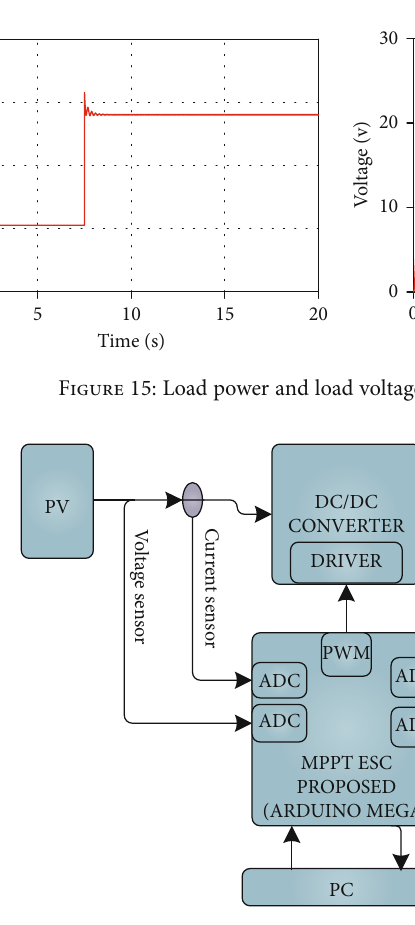
Figure 16: Experimental architecture. Table 3: DC/DC converter characteristics.